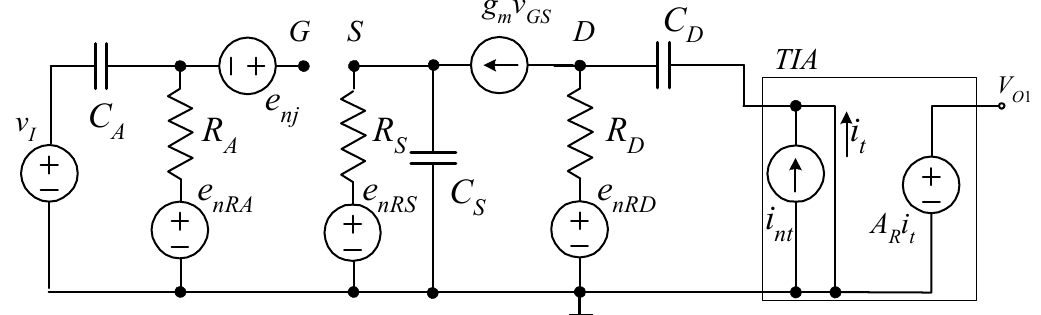
Figure 2. Small signal equivalent circuit of the amplifier in Figure 1. All relevant noise sources are shown in the figure. The noise sources e nRX account for the thermal noise introduced by the resistances R X ; the source e nj is used to model the noise introduced by the JFET; the source i nt is used to model the noise introduced by the transimpedance amplifier (TIA).